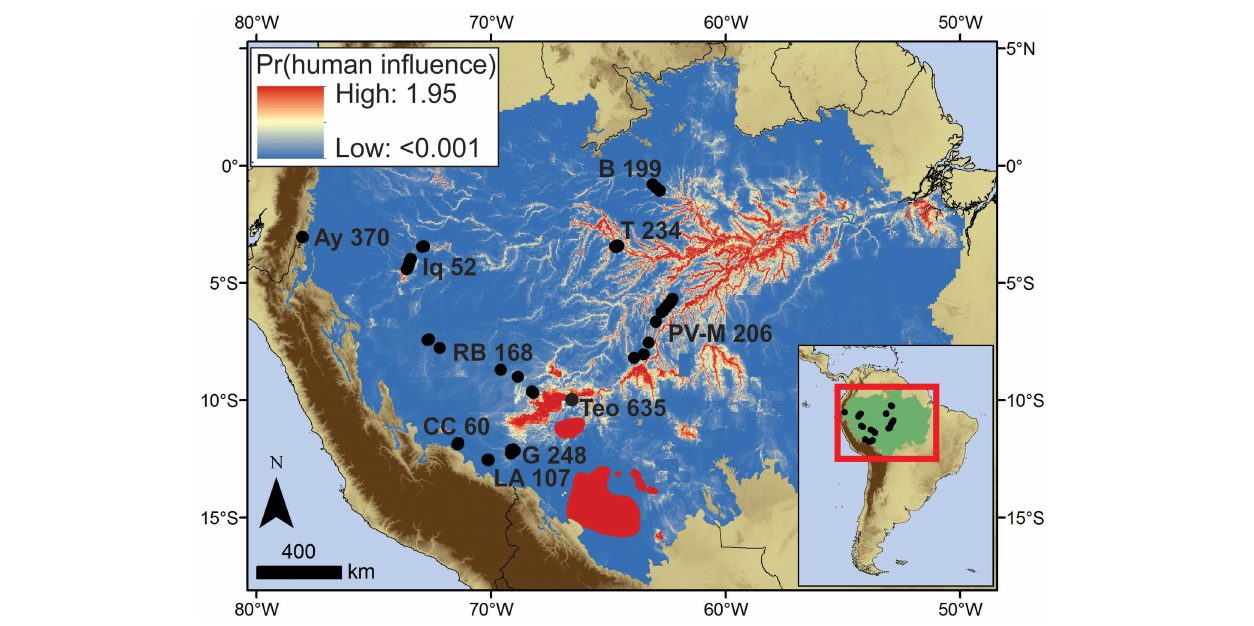
FIGURE 7 | Summed probabilities of predictive models of terras pretas (McMichael et al., 2014a), geoglyphs (McMichael et al., 2014b), and major archeological sites (Roosevelt et al., 1991, 1996; Erickson, 2006; Heckenberger et al., 2008) within Amazonia sensu stricto . The highest probabilities indicate where anthropogenic influence on past, and potentially present, vegetation is most likely based on available data. It is worth noting, however, that additional unreported data on archeology that could be used to refine this model within regions of Amazonia, and extend the predictions into the regions surrounding